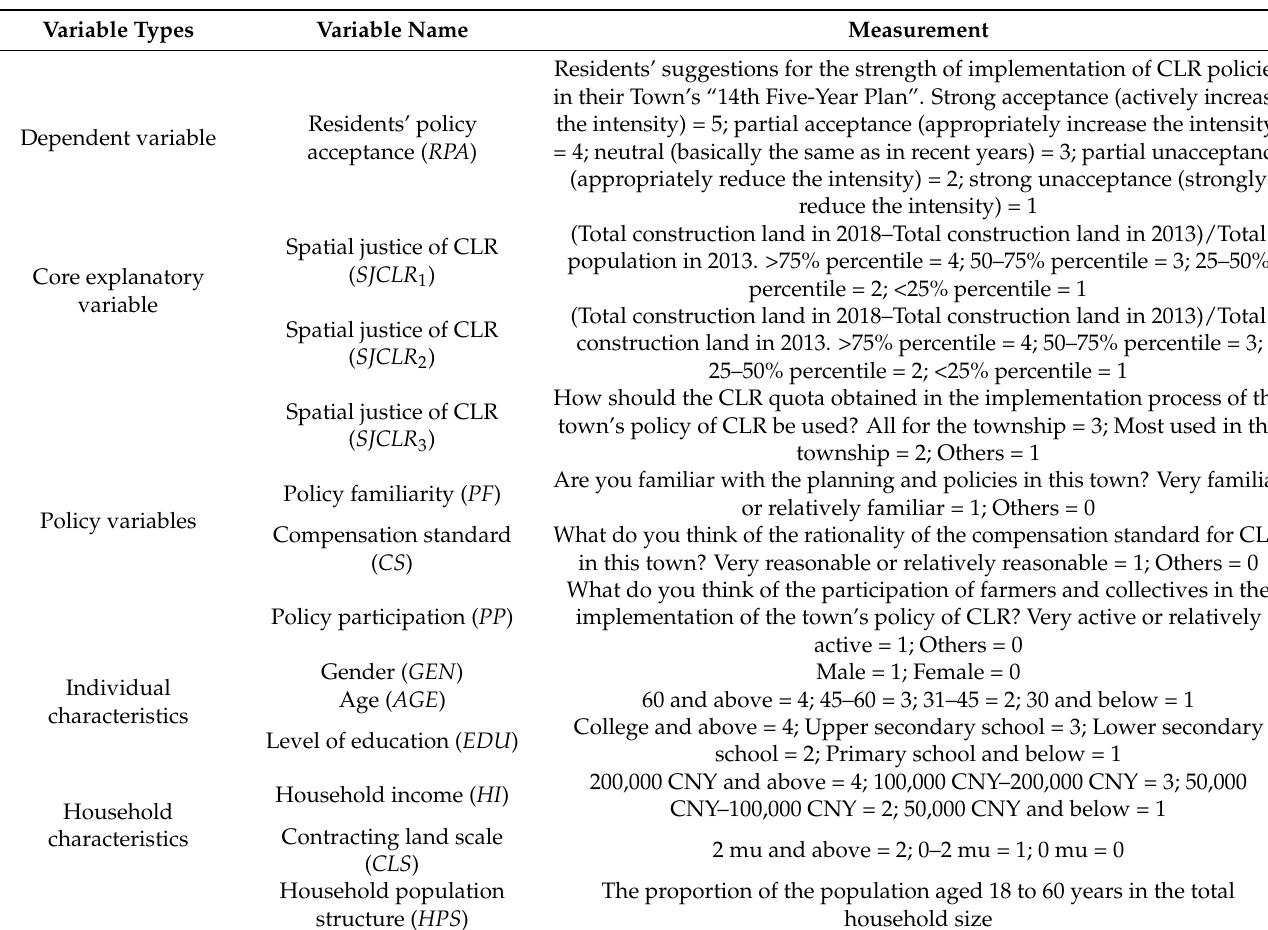
Table 1. Description of model